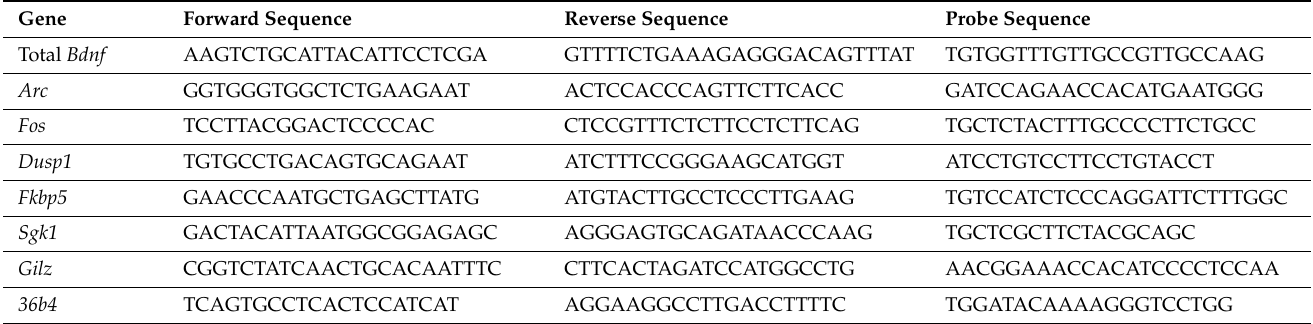
Table 1. Primers and probes sequences acquired from Eurofins MWG-Operon.